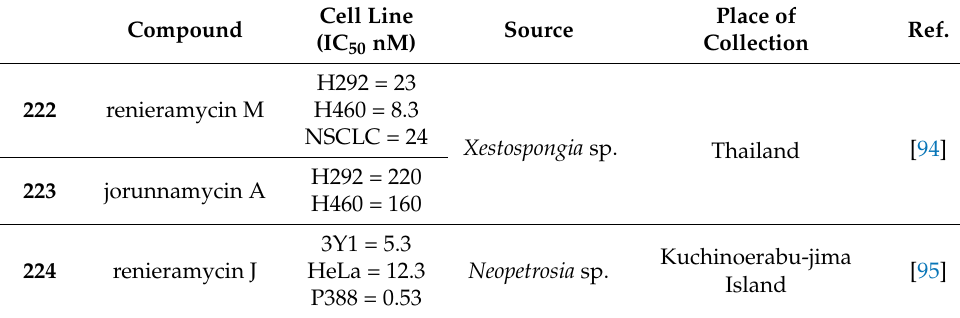
Figure 16. Tetrahydroisoqouinoline alkaloid structures isolated from sponges. Table 16. Cytotoxic activity of tetrahydroisoqouinoline alkaloids.